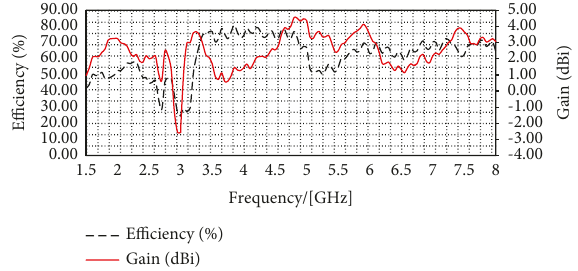
Figure 14: Gain and efficiency of antenna in measured